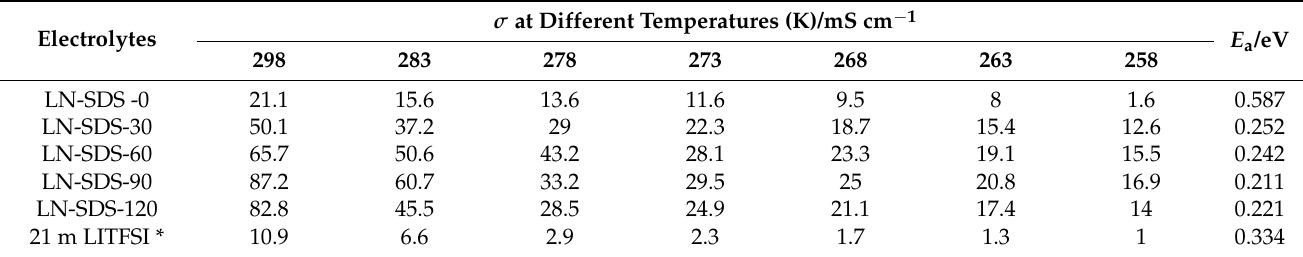
Table 2. σ and E a values of the electrolytes at different